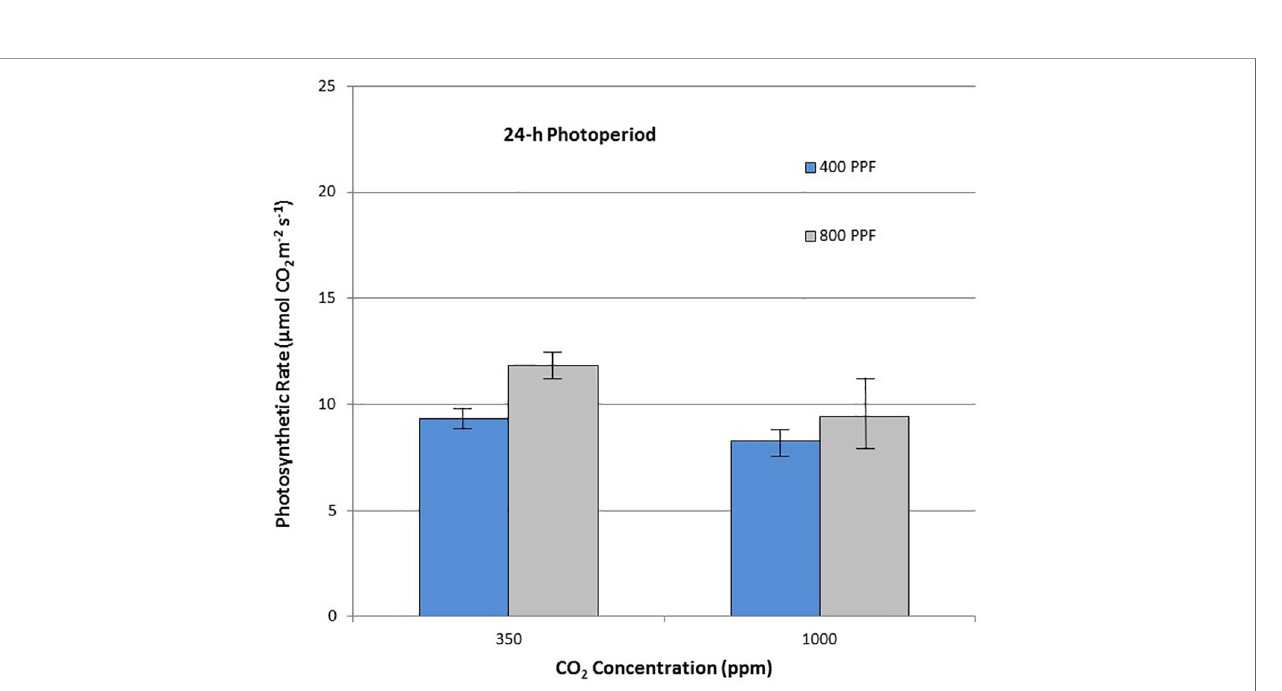
FIGURE 7 | Comparison of time-averaged leaf net photosynthetic rates taken at 21, 28, 35, 42, 56, 70, and 84 days after planting for all cultivars grown under 24-h (continuous) light at two [CO 2 ] concentrations, and two photosynthetic photon fl ux (PPF) levels. A total of n = 36 measurements were taken at each of the 7 dates, for a total 252 total measurements. Error bars indicate the standard error of the mean for average measurements at each